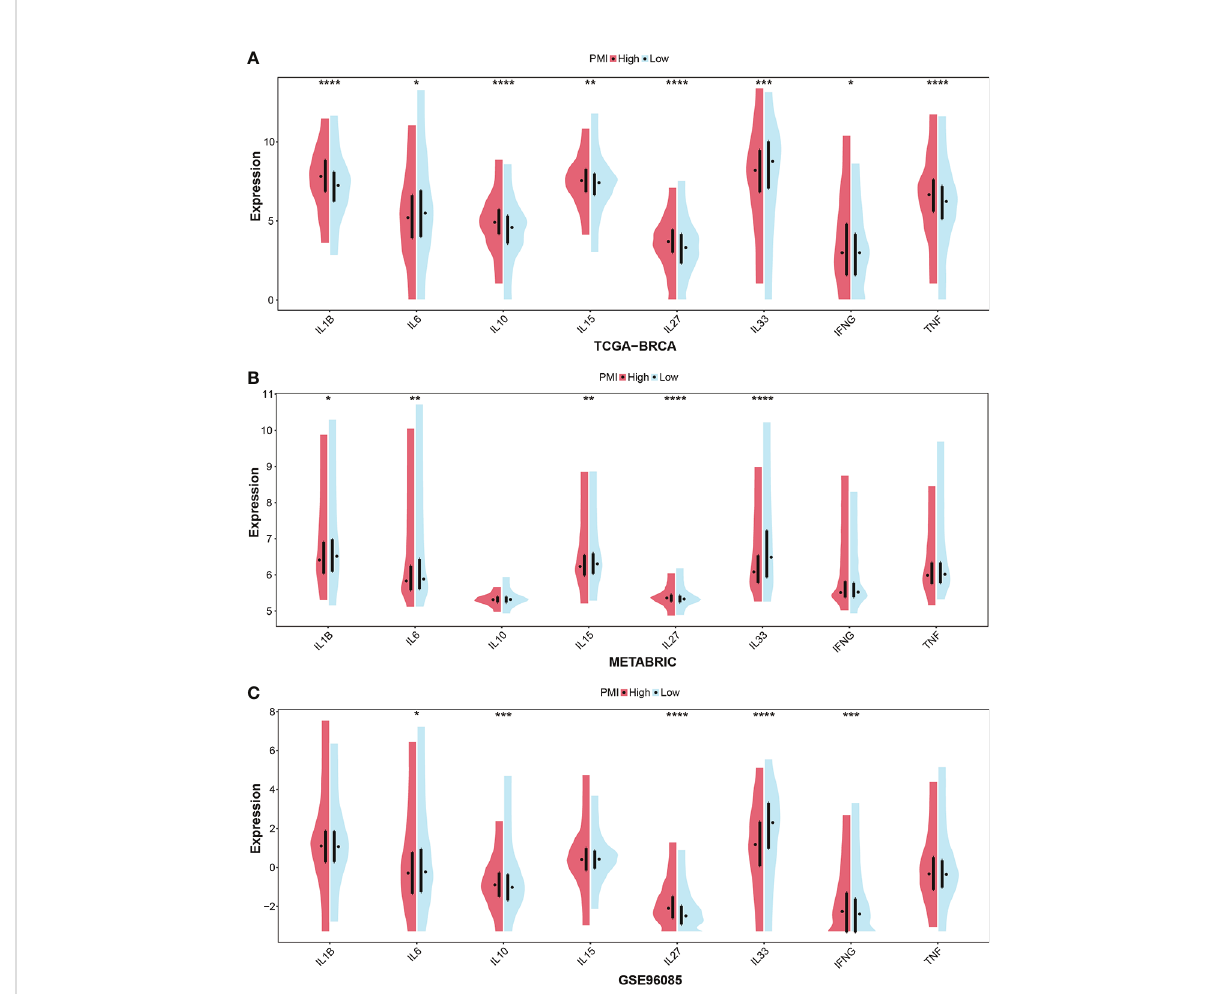
FIGURE 10 Investigation of essential cytokines in TME according to PMI levels. Comparison between the mRNA expression levels of IL-1B, IL-6, IL-10, IL-15, IL-27, IL-33, IFNG, and TNF between high- and low-PMI groups were explored in TCGA-BRCA (A) , METABRIC (B) , and GSE96058 (C) datasets separately. *p< 0.05; **p< 0.01; ***p< 0.001; ****p<